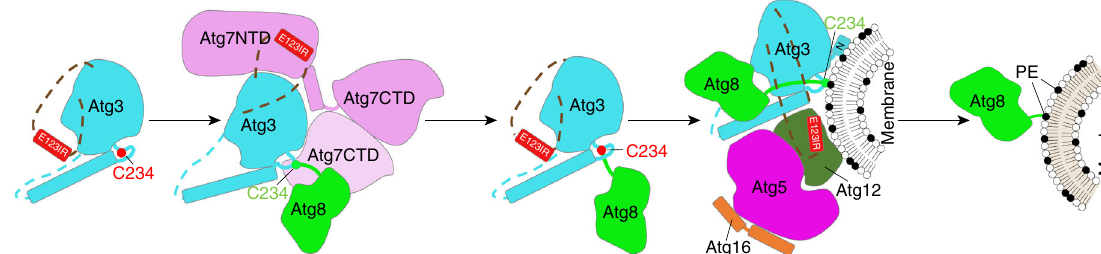
Fig. 9 Schematic model for allosteric regulation of Atg3 activity through E123IR interactions across the lipidation cascade. The autophagy E2 Atg3 is autoinhibited by Atg E123IR . When Atg3 encounters E1 Atg7, E123IR is relocated upon binding to Atg7 NTD , thereby triggering rearrangement of the Atg3 catalytic core to activate Cys234 for attacking the Atg7 – Atg8 intermediate. Atg8 is transferred from Atg7 to Atg8, producing the thioester-bonded Atg3~Atg8 intermediate. Relieved from Atg7, Atg3 E123IR protects the Atg3~Atg8 intermediate from wayward discharge to errant nucleophiles. The E3 (Atg12 – Atg5-Atg16) binds E123IR and further activates the Atg3~Atg8 intermediate for nucleophilic attack. Numerous interactions with membranes place this complex in proximity to PE for the